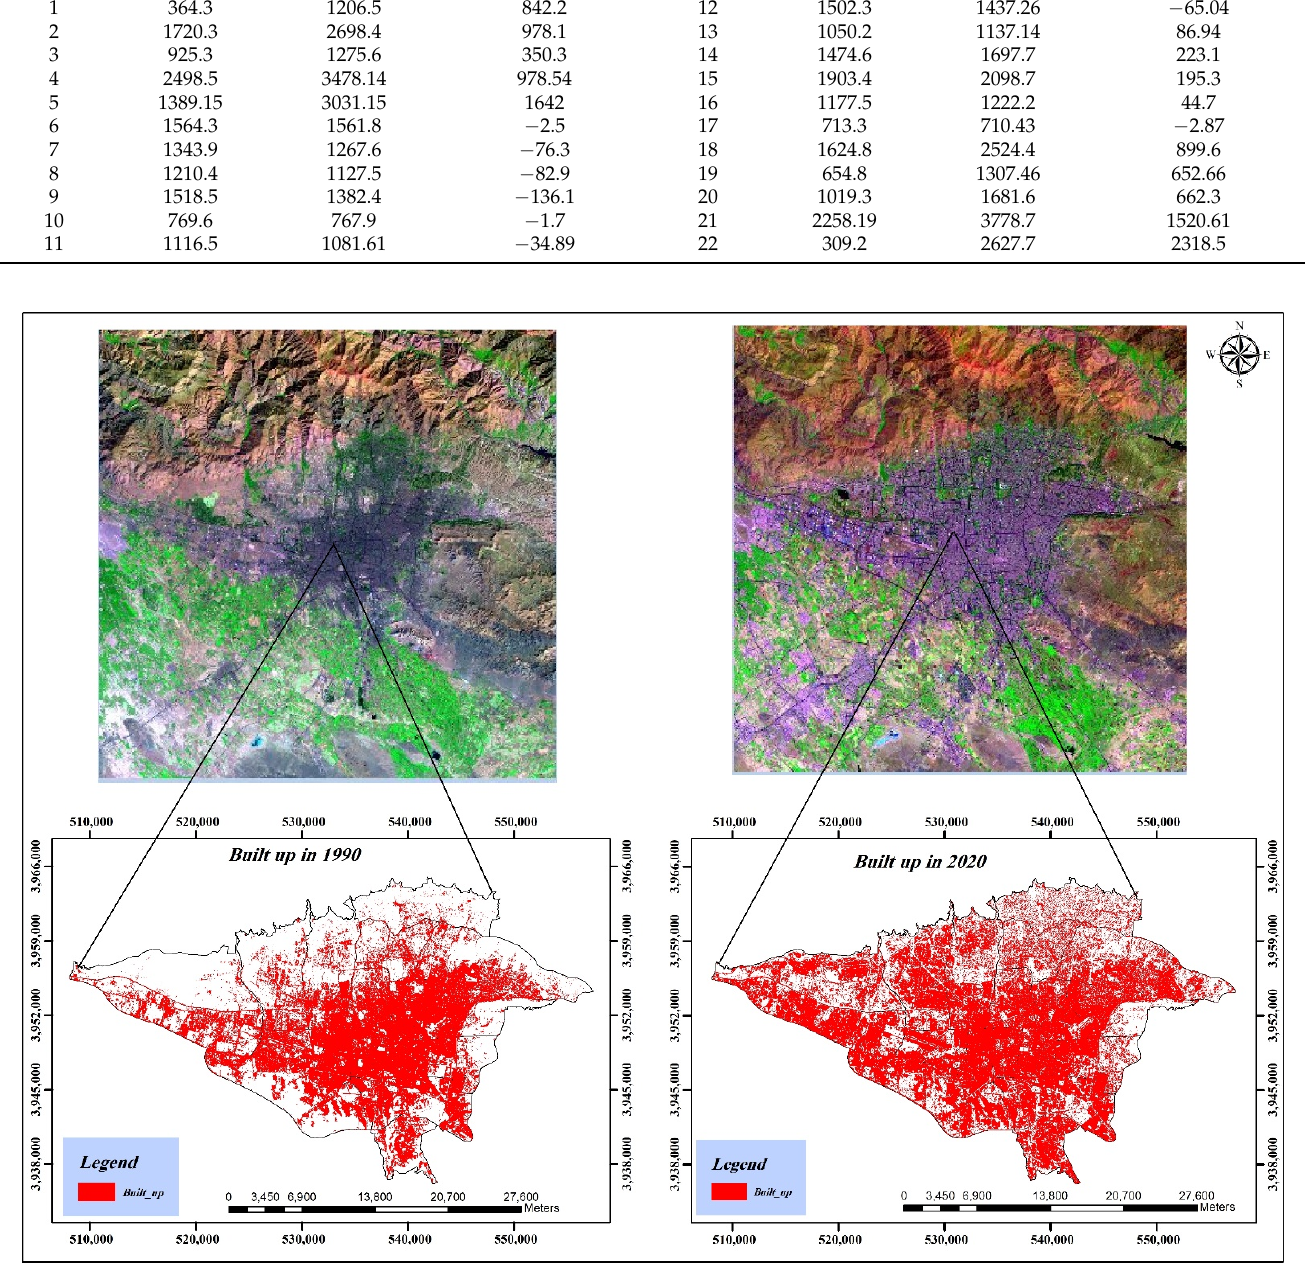
Figure 4. Satellite images and the growth trends of the constructed lands in the metropolis of Tehran for the periods 1990 and 2020.